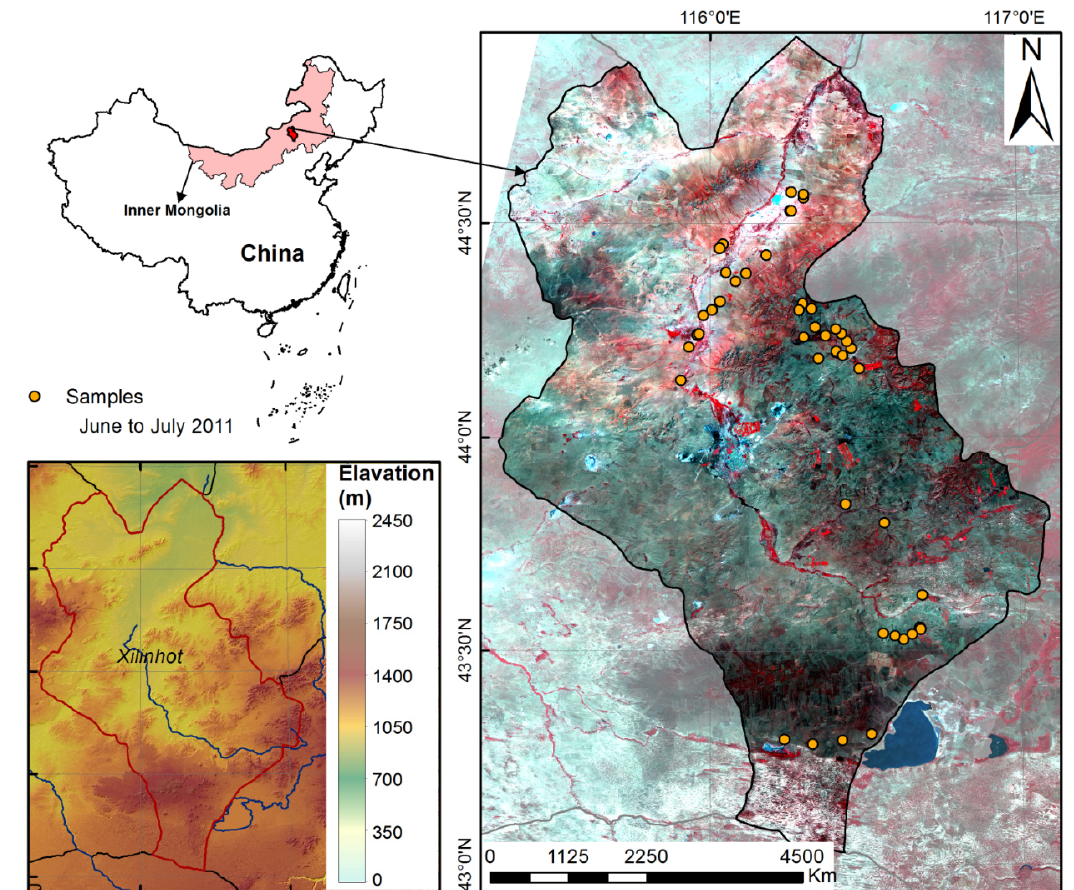
Figure 1. The location of Xilinhot. The elevation in the left-bottom corner was generated by using Shuttle Radar Topography Mission (SRTM) data (http://srtm.csi.cgiar.org/). The image on the right is the RGB (red, green, blue) composite of Landsat bands 5, 4, and 3 overlaid with field locations (orange dots) where samples were collected in 2011.